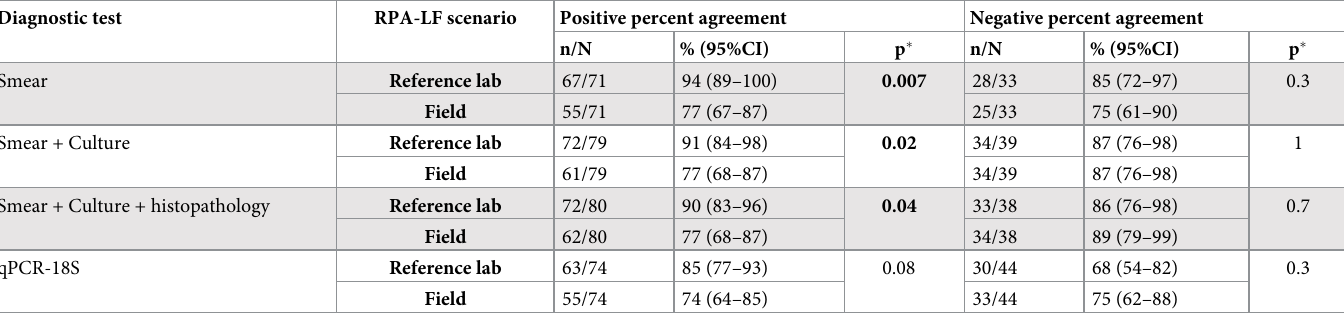
Table 4. Agreement between RPA-LF test and other diagnostic